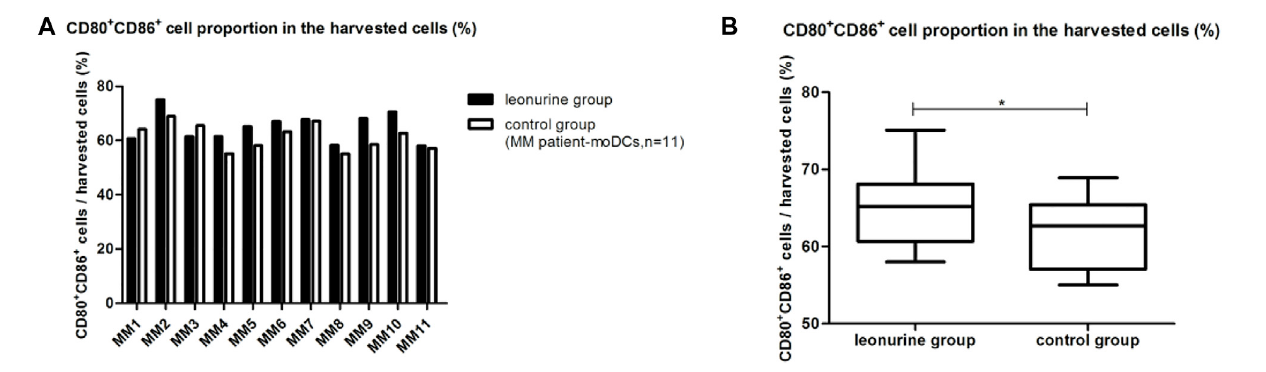
FIGURE 8 The proportion of moDCs in the harvested cells between the leonurine group and the control group (MM patient-moDCs, n = 11). (A) The graph shows the proportion of moDCs in the harvested cells between the leonurine group and the control group for each MM patient. (B) The boxplot shows that when moDCsderivedfromall11 MMpatientswereanalyzedtogether,theproportionofmoDCsintheharvestedcellswassigni fi cantlyhigherintheleonurinegroup than in the control group (64.86% ± 5.41% vs. 61.39% ± 4.86%, p = 0.029, paired-sample t -test).